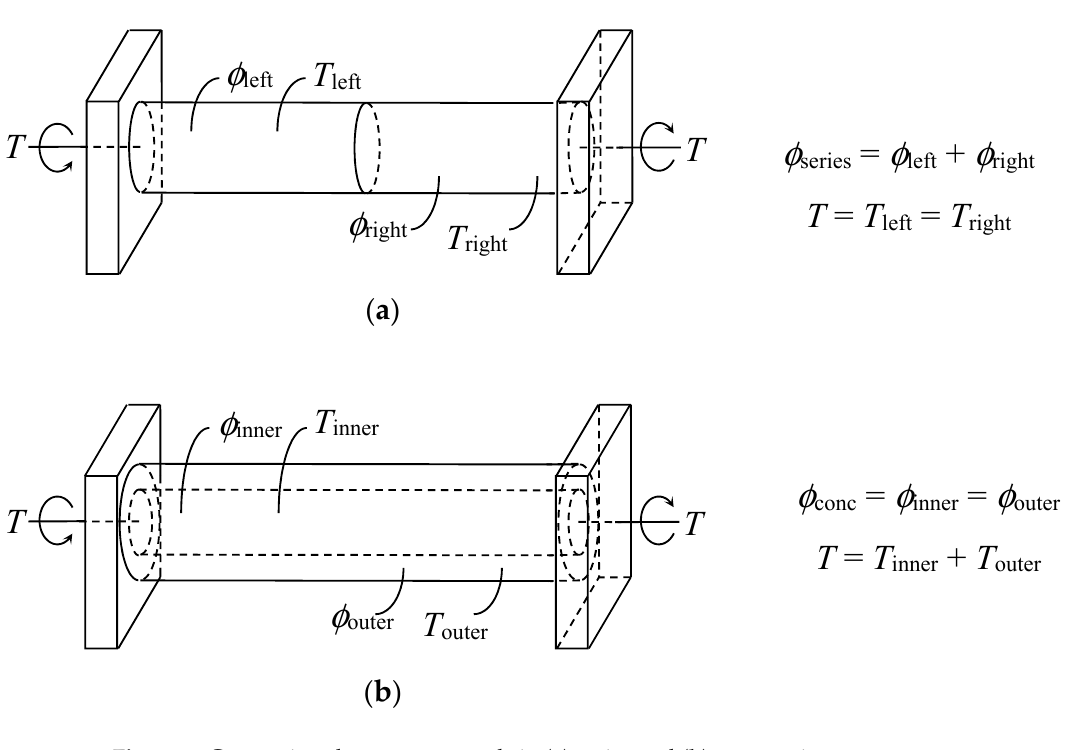
Figure 2. Comparison between two rods in ( a ) series and ( b ) concentric arrangement.